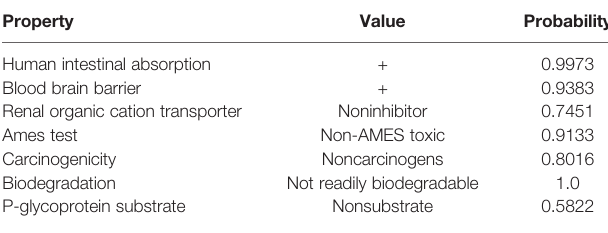
TABLE 2 | The ADMET data is predicted using admetSAR, a free tool for evaluating chemical ADMET properties. This three line watch is still short of a bottom line. Property